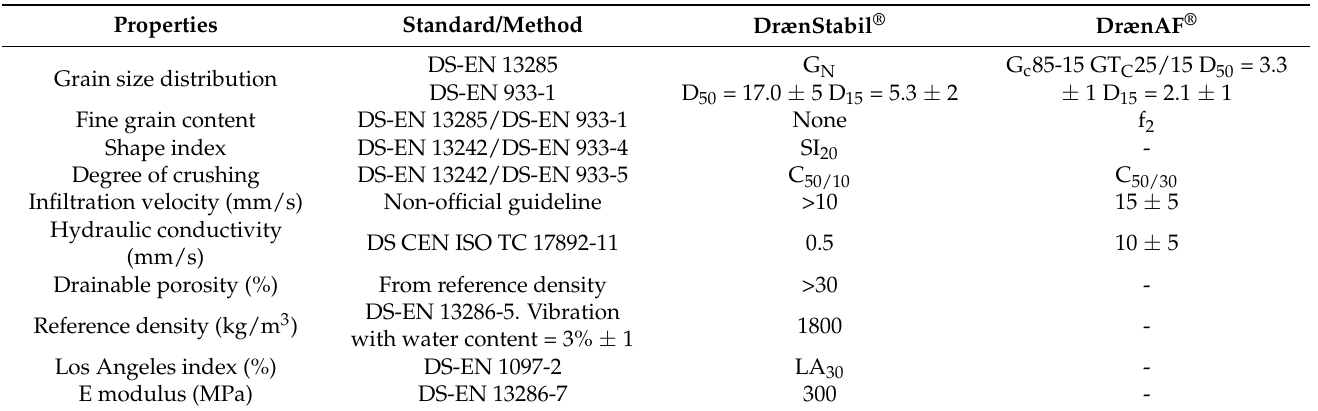
Table 1. Technical declarations for the roadbed materials. DS refers to Danish standards, which are available in English at https://www.ds.dk/en/about-standards, accessed on 3 May 2022. DrænStabil and DrænAF are registered trademarks of the NCC